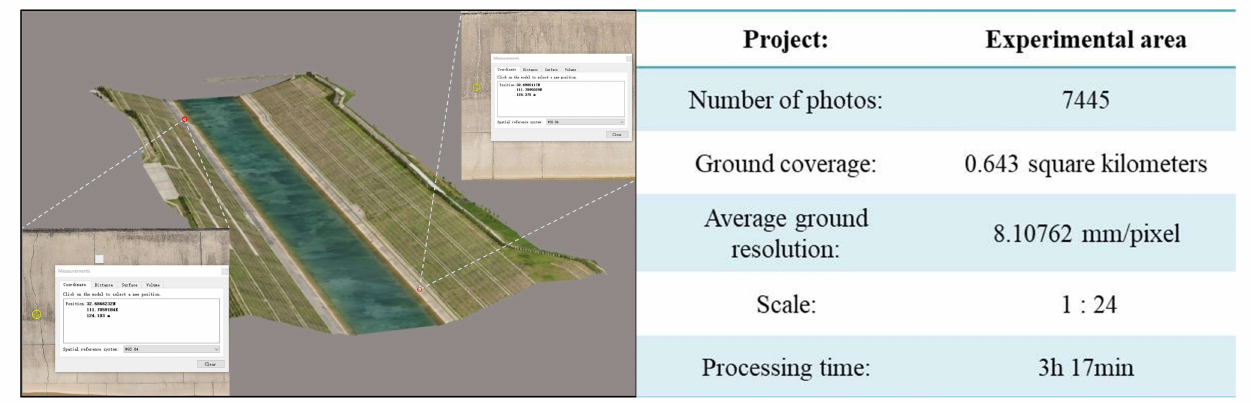
Figure 14. Three-dimensional model of the experimental area and its accuracy